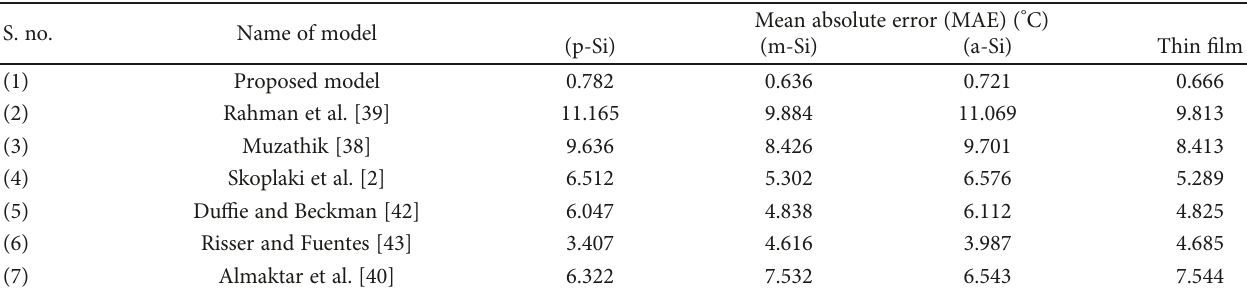
Table 8: Mean absolute error (MAE) of each PV module in winter. S. no.